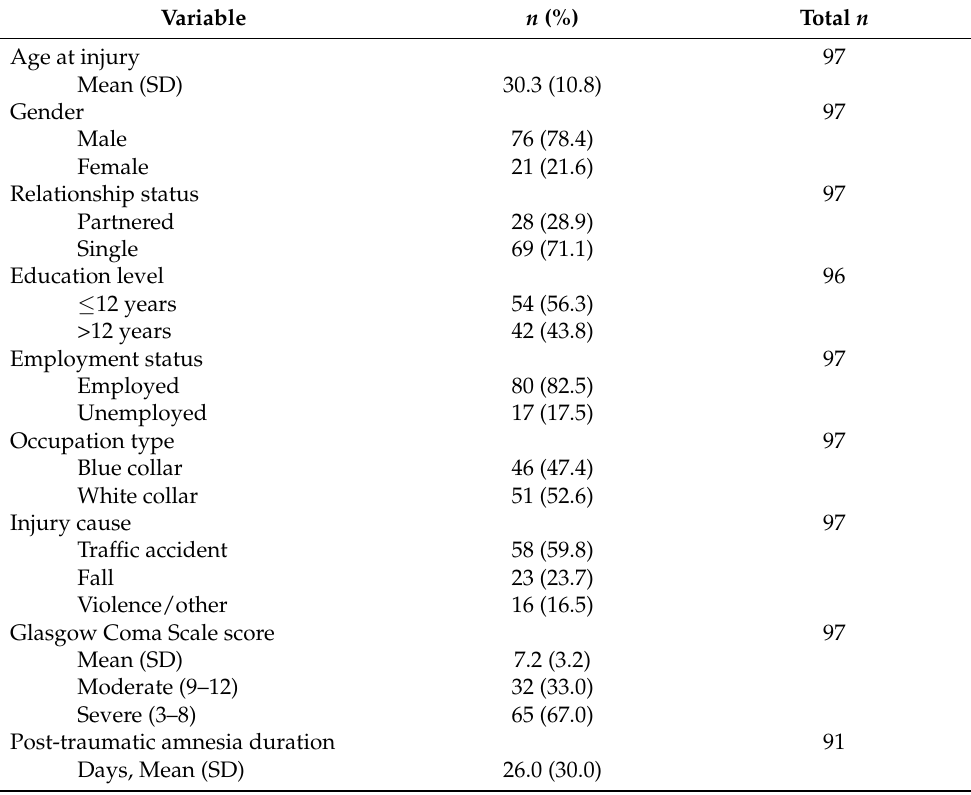
Table 1. Socio-demographics at the time of injury and the injury characteristics.